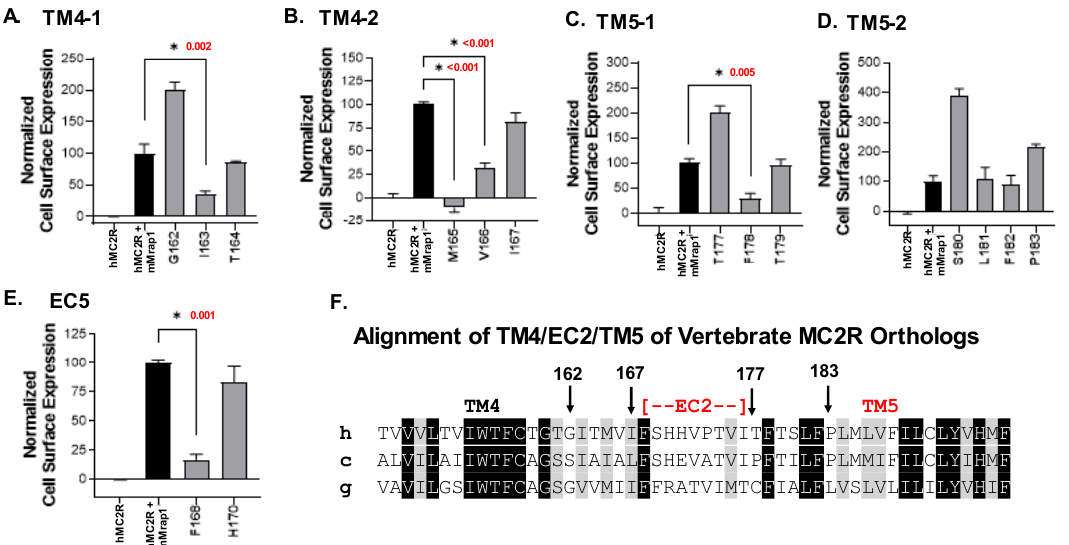
Figure 4. Cell Surface ELISA Analysis of Single-Alanine mutants of hMC2R. The Cell Surface ELISA analysis was performed as described in Methods. The negative control was hMC2R expressed alone. The positive control was hMC2R co-expressed with mMrap1. All of the single alanine mutant forms of hMC2R were co-expressed with mMRAP1. The one-way ANOVA p values for mutants that results in a decrease in trafficking relative to the positive control are shown in red. ( A ) Analysis of TM4 single alanine mutants G 162 /A 162 , I 163 /A 163 , and T 164 /A 164 . ( B ) Analysis of TM4 single alanine mutants M 165 /A 165 , V 166 /A 166 , and I 167 /A 167 . ( C ) Analysis of TM5 single alanine mutants T 177 /A 177 , F 178 /A 178 , and T 179 /A 179 . ( D ) Analysis of TM5 single alanine mutants S 180 /A 180 , L 181 /A 181 , F 182 /A 182 , and P 183 /A 183 . ( E ) Analysis of EC2 single alanine mutants F 168 /A 168 and H 170 /A 170 . ( F ) Alignment of the TM4/EC2/TM5 domains of human MC2R (h), Gallus gallus (chicken; c) Mc2r, and Lepisosteus osseous (gar; g) Mc2r. As described in the legend to Figure 3, amino acid positions that are identical are highlighted in black, and amino acid positions that are highlighted in grey are similar based on BLOSUM analysis. * indicates statistical decrease in trafficking relative to the positive